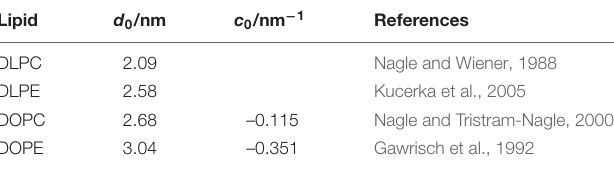
TABLE 4 | Thickness and intrinsic curvature of diacyl-PC and -PE